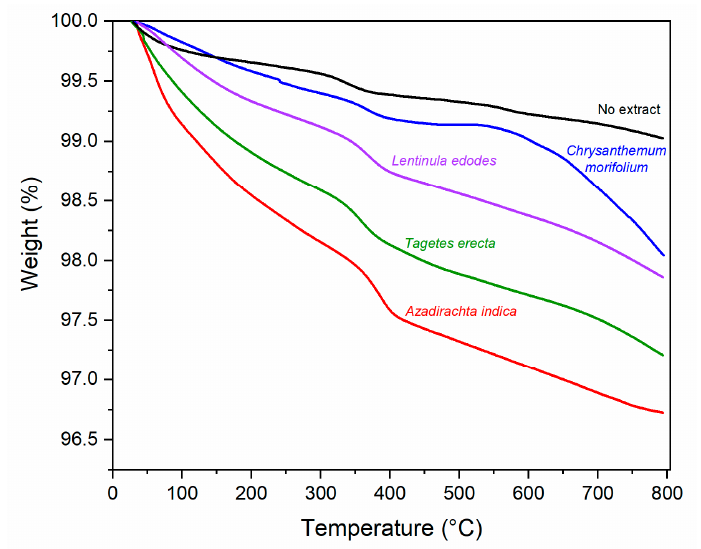
Figure 6. TGA thermograms of ZnO NPs synthesized with no extract and different botanical ex- tracts .